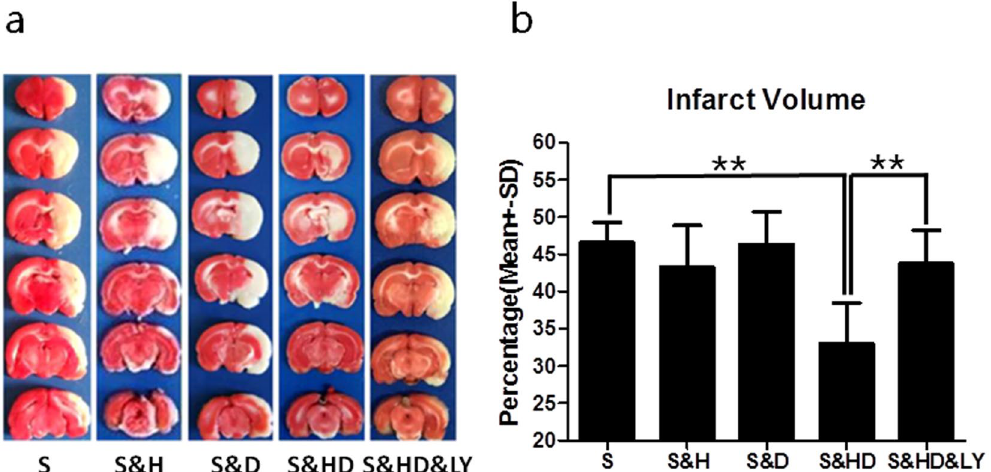
Figure 2. Infarct volume reduction by combination therapy of mild hypothermia and C + P. ( a ) TTC histology demonstrating infarct volume reduction in the penumbra region of ischemic territory supplied by MCA with mild hypothermia (S&H), C + P (S&D), combination therapy (S&HD), and combination therapy + p-Akt inhibitor (LY294002) (S&HD&LY). ( b ) Percentage of infarct volume reduction (Mean ± SD) with mild hypothermia (S&H), C + P (S&D), combination therapy (S&HD), and combination therapy + p-Akt inhibitor (LY294002) (S&HD&LY). Combination therapy largely and significantly reduced the infarct volume, and treatment with LY294002 reversed the combination therapy’s neuroprotective effect, implicating a role in the PI3K / Akt signaling pathway. ** P < 0.01, n = 7 per group.